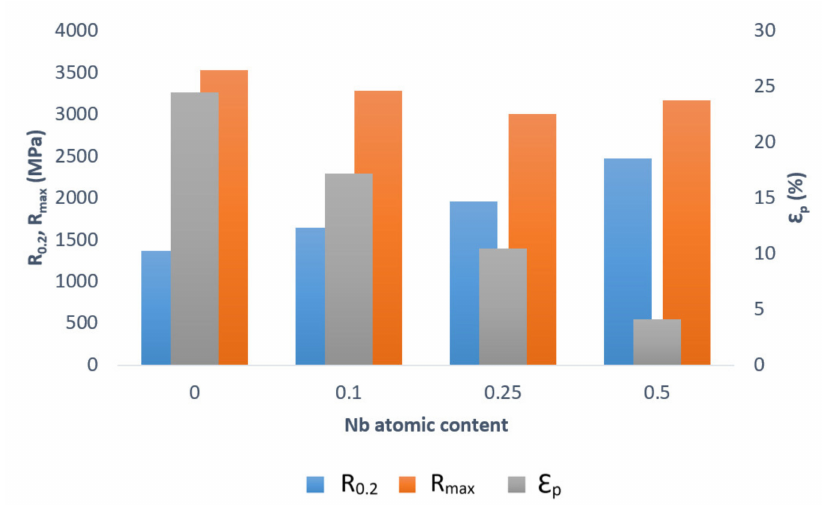
Figure 3. Effect of niobium content on the mechanical properties of the AlCoCrFeNb x Ni alloys (based on